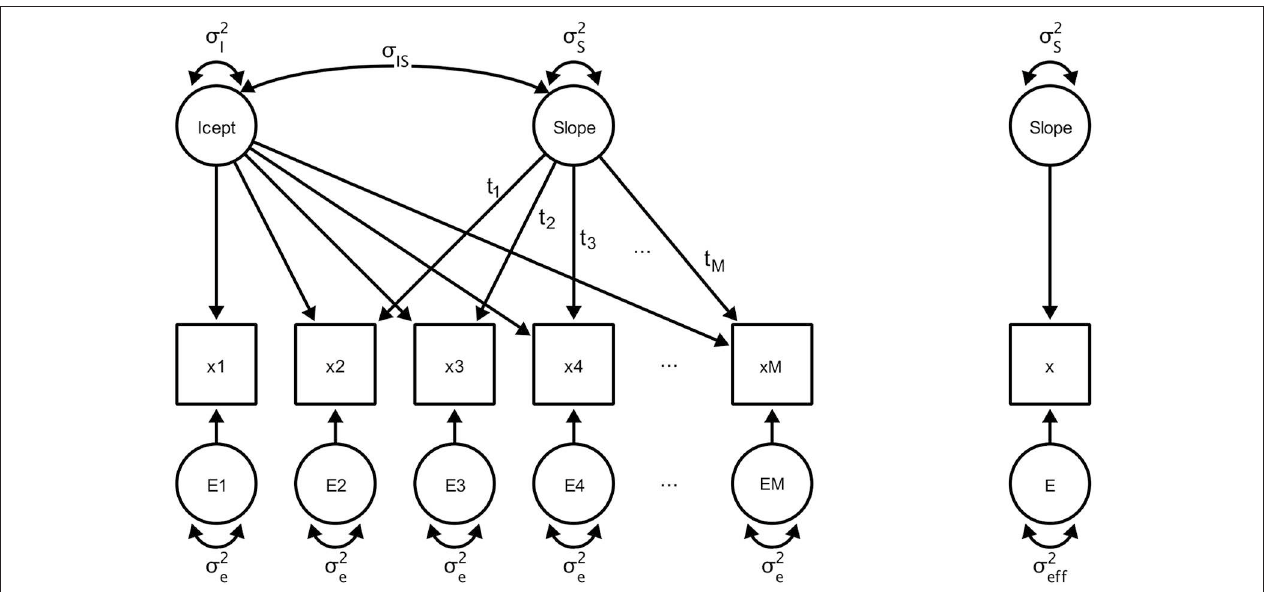
FIGURE 2 | Left : A LGCM with a latent intercept “Icept” with variance σ 2 I and a latent slope “Slope” with variance σ 2 S , and intercept-slope covariance σ IS . A single variable is observed for a total of M occasions of measurement (labeled x1 to xM) and an error term with variance σ 2 e . Right : A hypothetical minimal and power-equivalent model representing a design in which the slope is measured directly with a single source of effective